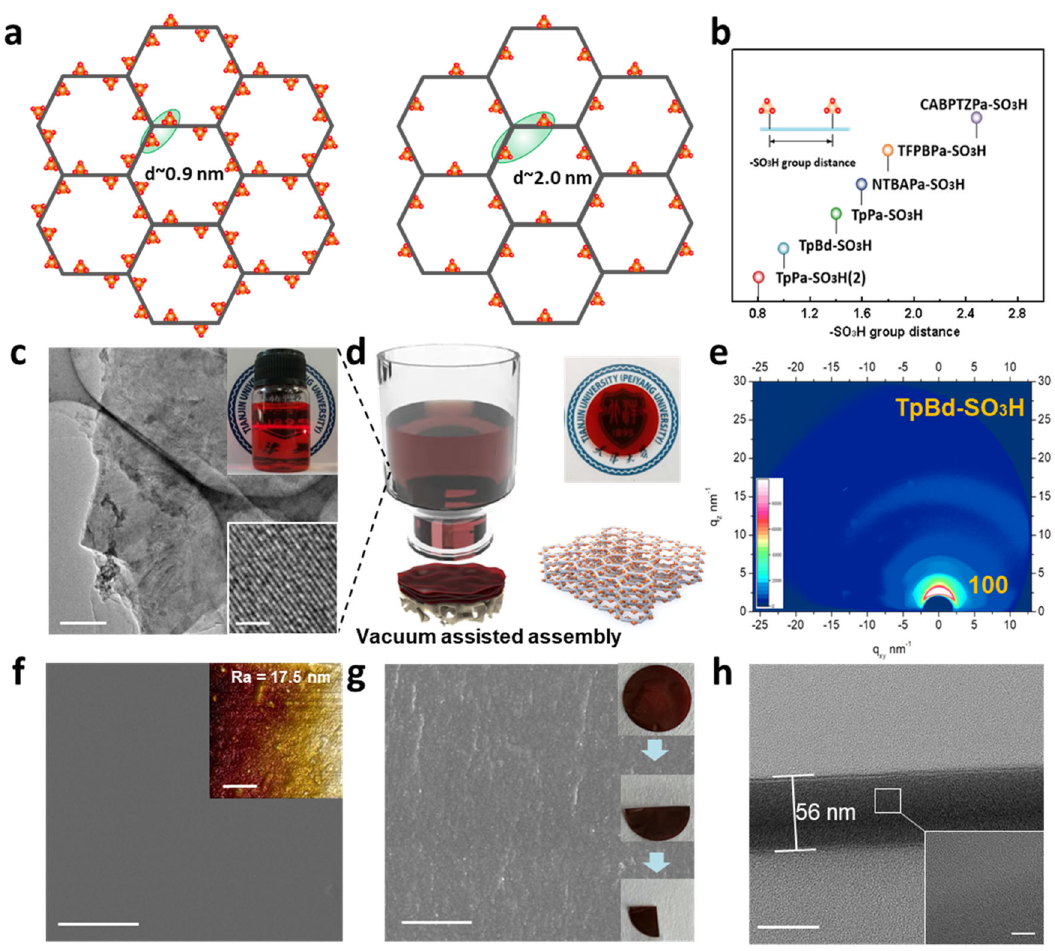
Fig. 2 | Preparation and characterizations of iCOF nanosheets and iCOFMs. a Topological structures of the iCOFs with twelve and six -SO 3 H groups on each hexagonal unit, respectively(the green ellipse represents the -SO 3 H groups dis- tance). b Schemeofthe-SO 3 HgroupdistanceiniCOFsskeleton. c TEMimageofthe iCOF nanosheets (scalebar, 500nm,2nm).The upper and lowerinsets displaythe photograph of the iCOFs nanosheet solution and the HRTEM image of iCOFs nanosheets, respectively. d Scheme of the preparation of iCOFM. The upper and